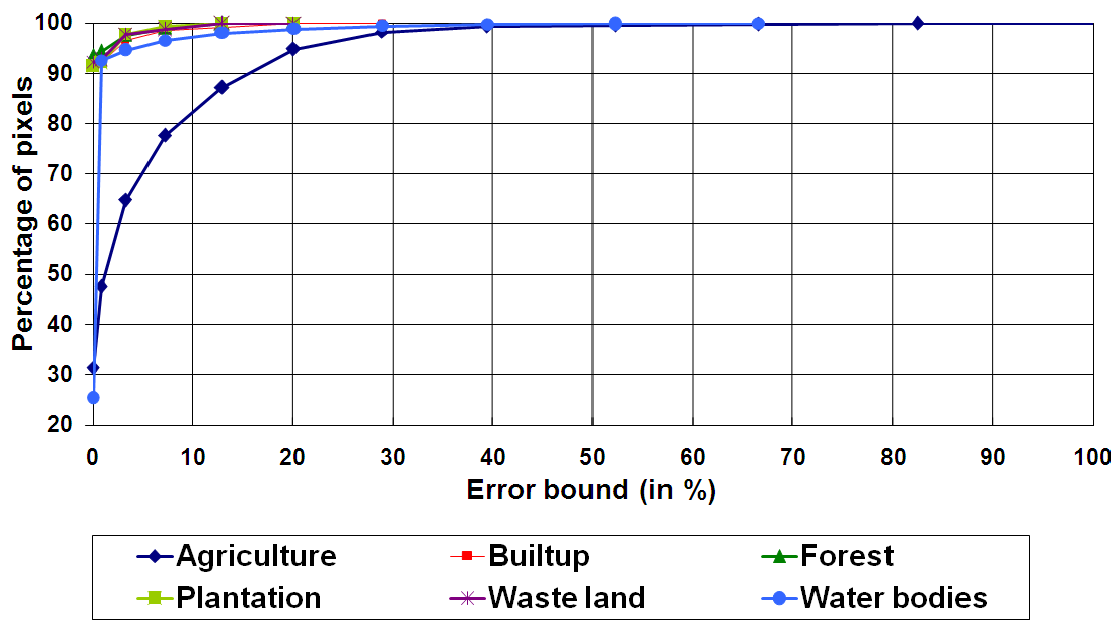
Figure 16. For the HMM, the graph shows the percent of pixels that lie within a given percent of the actual class